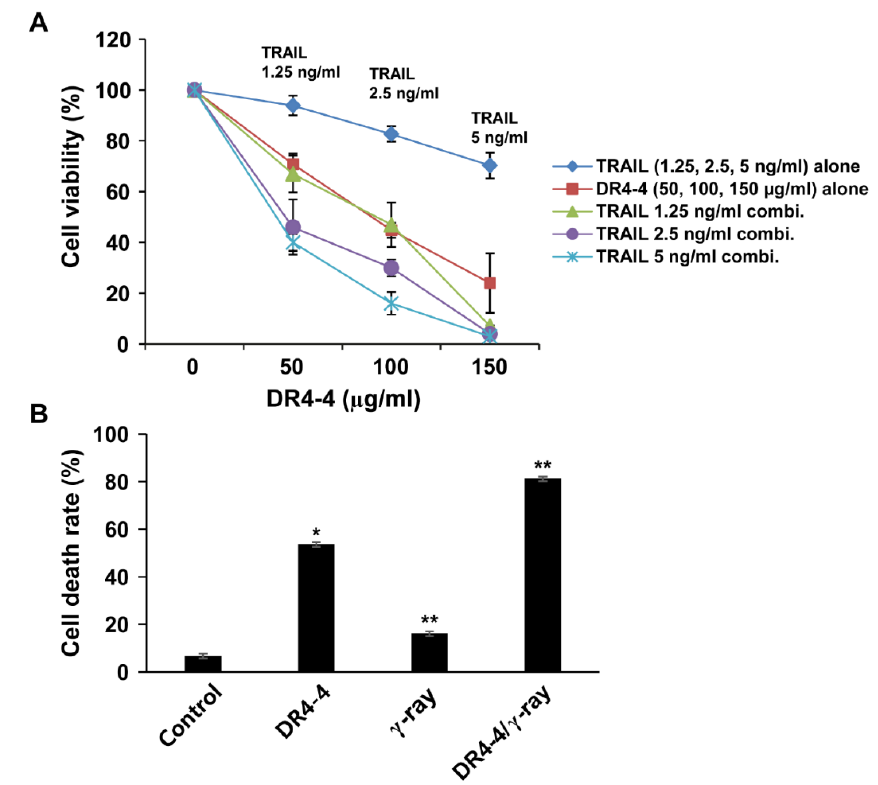
Figure 7. Enhanced rates of cell death following cotreatment with DR4-4 Fab and TRAIL or γ -irradiation. ( A ) Cytotoxicity of cotreatment with DR4-4 Fab and TRAIL as measured by MTT assay. Cell viability for single treatment with TRAIL is also presented with concentrations indicated (upmost line). ( B ) Cells pre-irradiated with γ-radiation (absorbed dose = 2 Gy) were treated with DR4-4 Fab (100 µg/mL) for 24 h. Cell death was measured by MTT assay. Data presented as mean ± standard deviation (* p < 0.05, ** p < 0.005, versus control).